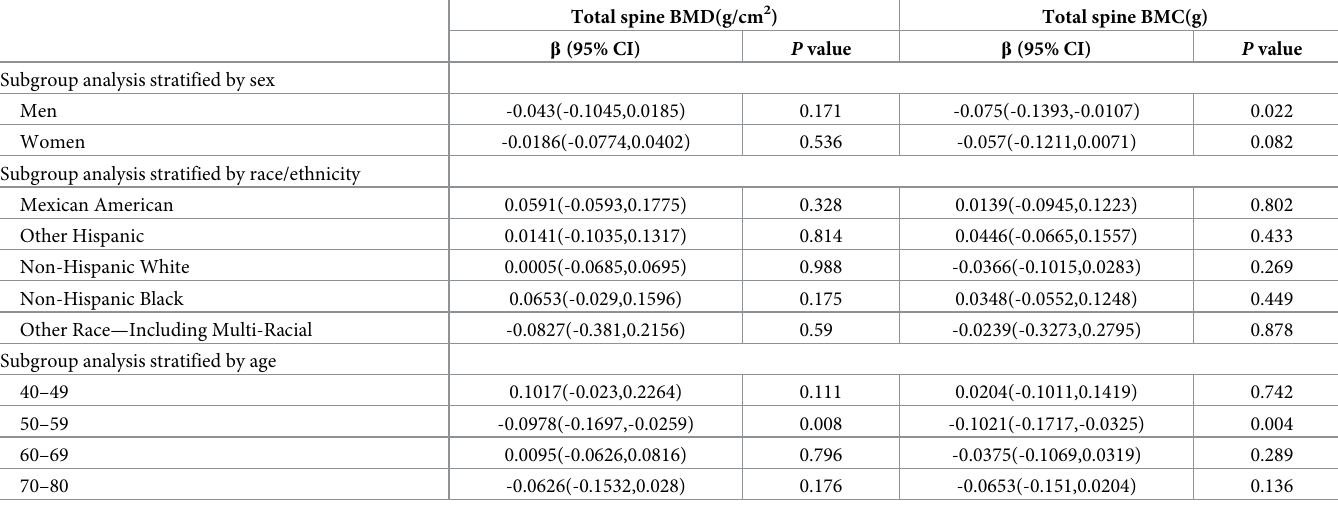
Table 5. Association of blood manganese with total spine BMD/BMC, stratified by sex, race/ethnicity and